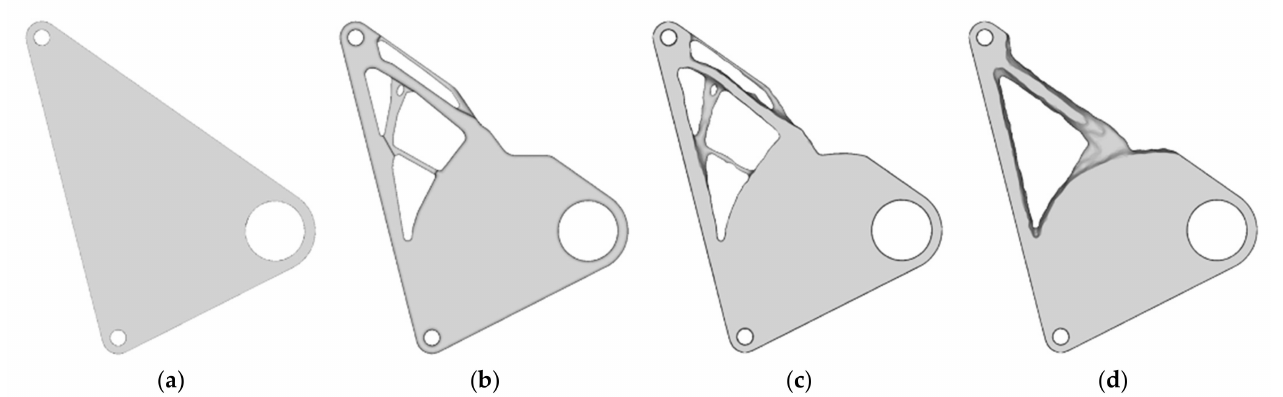
Figure 12. Tested configurations of the rocker. ( a ) reference; ( b ) redesigned; ( c ) smoothed; ( d )